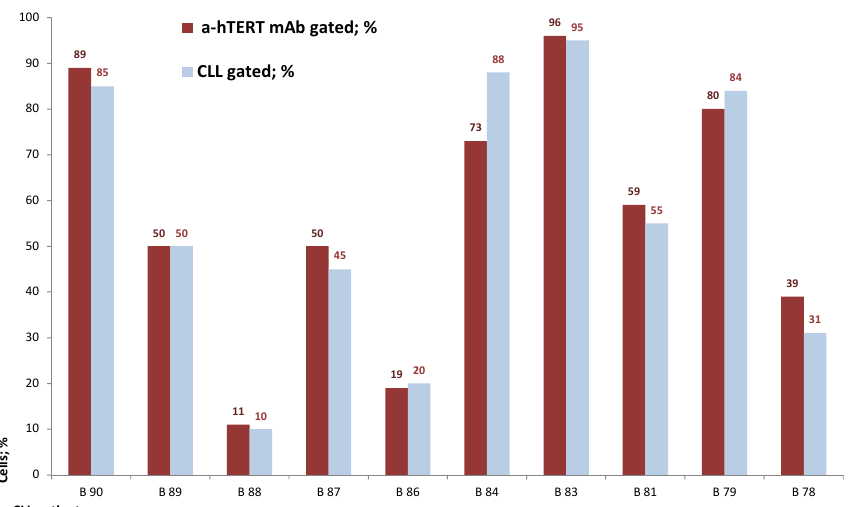
Figure 4. The percentage of the α -hTERT mAb positive cells corresponds to the percentage of the ex vivo obtained neoplastic (CLL: CD19+/CD5+) cells. A similar analysis as described in Figure 3 was conducted.